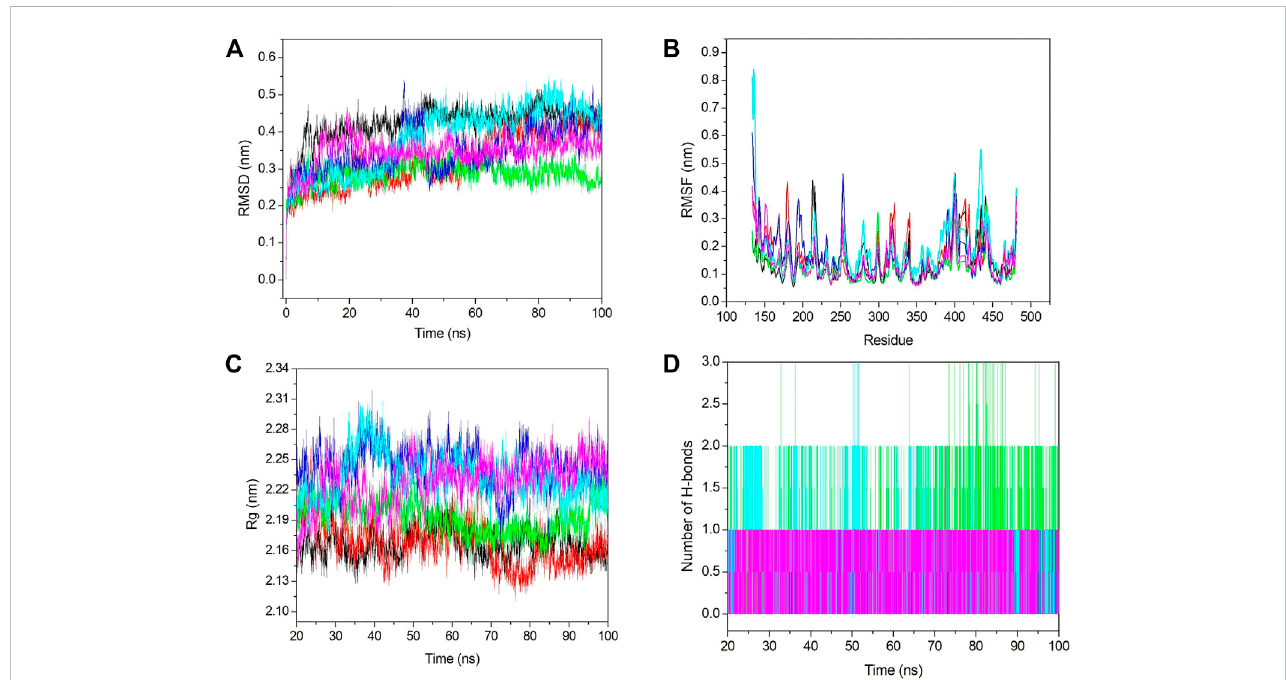
FIGURE 6 Stabilityanalysesofallthesystems. (A) RMSDvaluefor100 nsat300 K. (B) RMSFvaluefromthelast80 nstrajectory. (C) Radiusofgyration vs .thetimefor the last 80 ns. (D) Number of hydrogen bonds with respect to the time for all the selected hits including the control ligand. The black, red, green, blue, cyan, and pink colors represent apo – DYRK1A, DYRK1A – 4E3, DYRK1A – ZINC2123081, DYRK1A – ZINC3843365, DYRK1A – ZINC5220992, and DYRK1A – ZINC68569602,